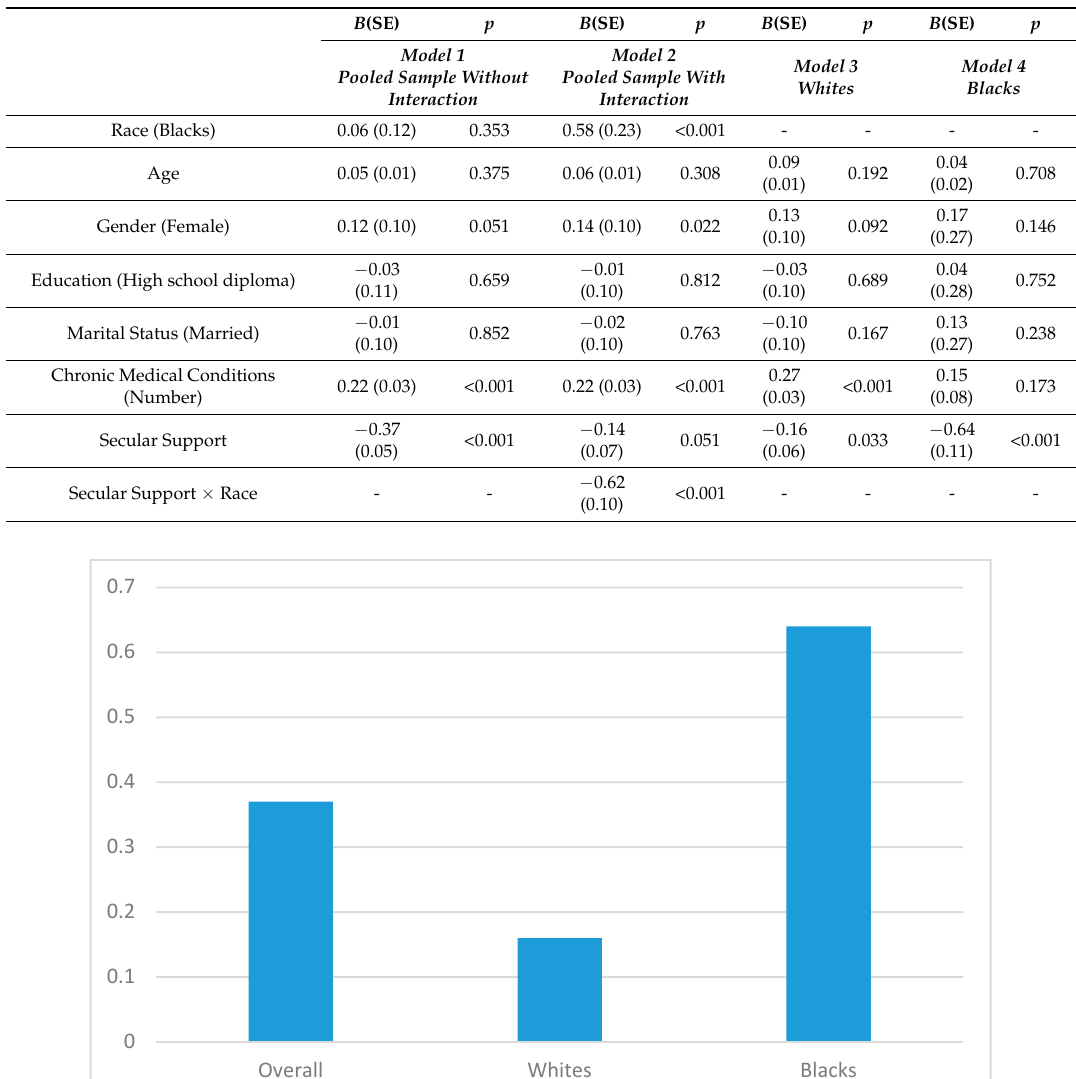
Table 4. Effects of secular social support on depressive symptoms based on race in older adults using linear regressions.